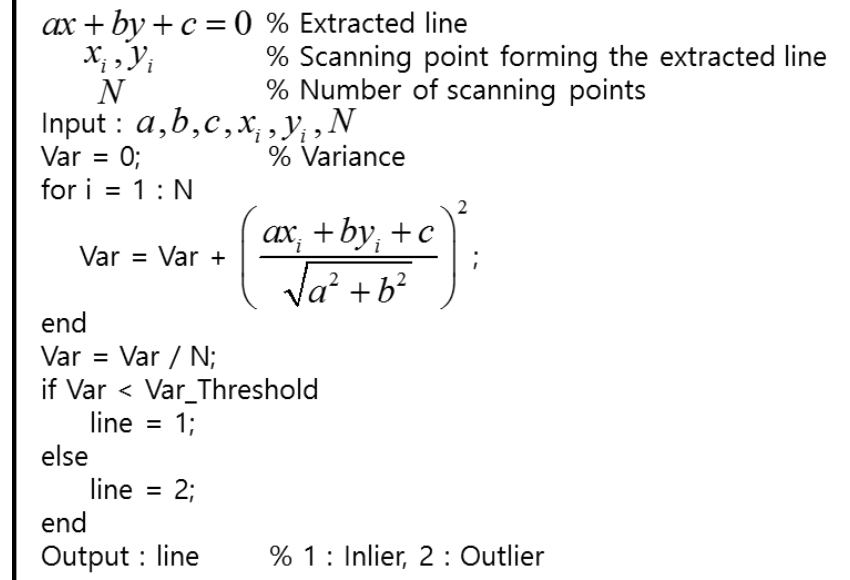
Figure 13. Pseudocode for outlier removal.